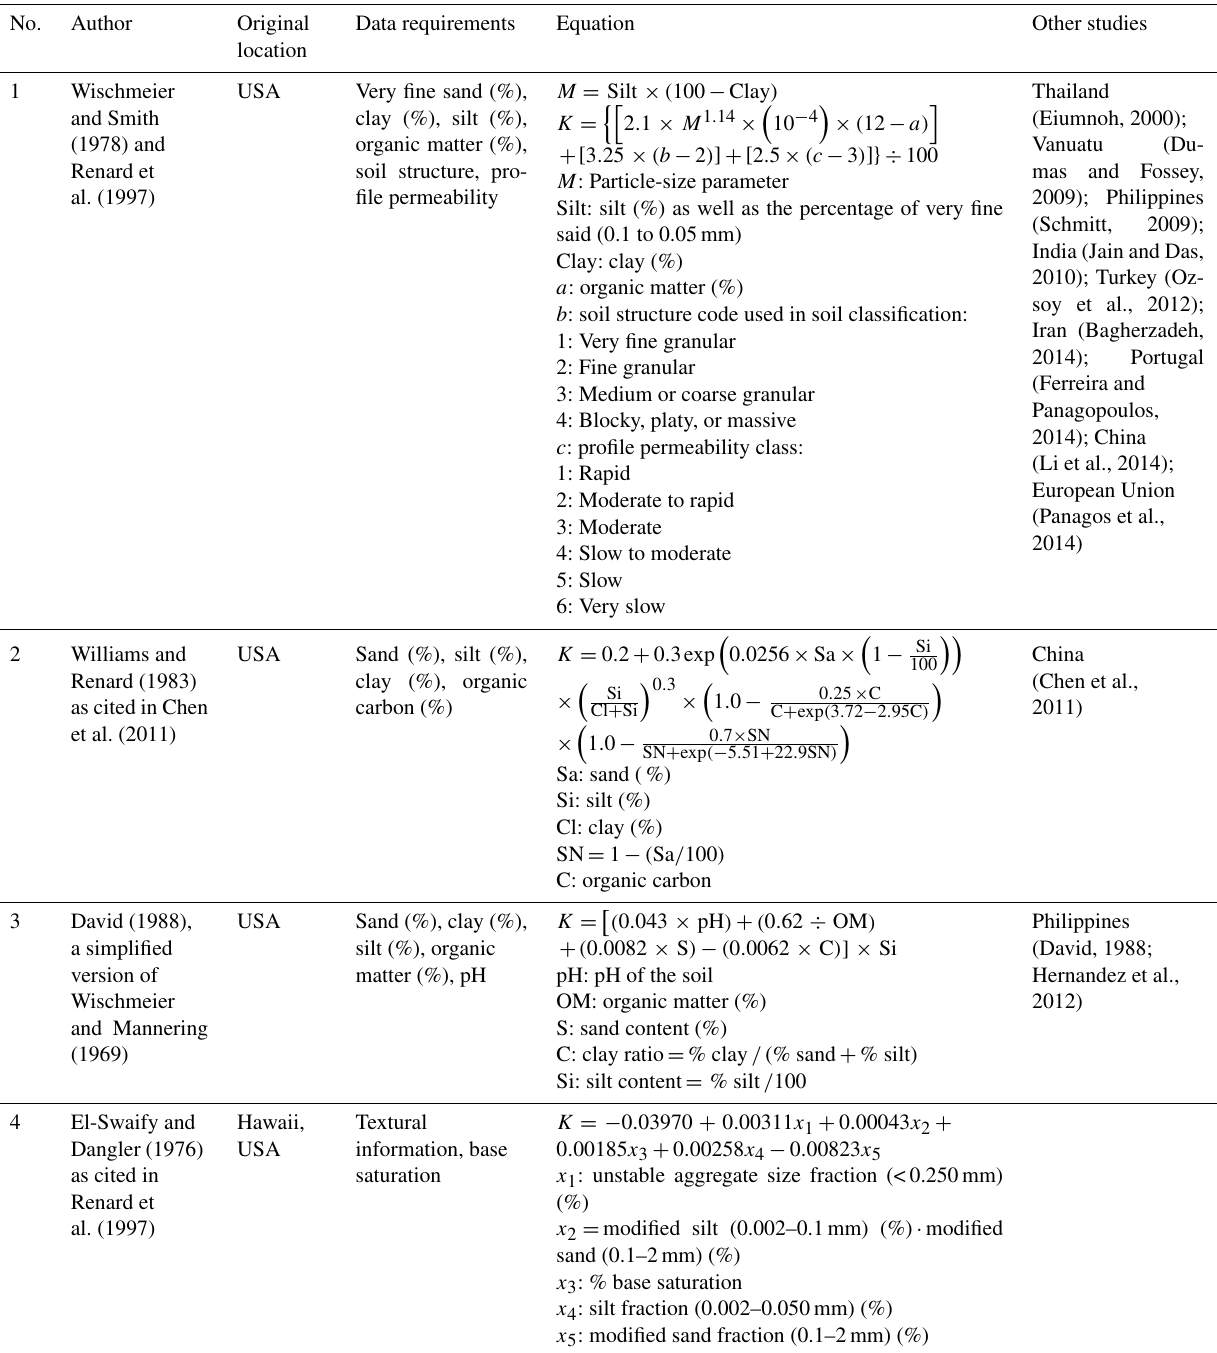
Table 3. Summary of different studies with soil erodibility equations, original locations, and other studies that used their equations. All of the equations in Table 3 use imperial units of soil erodibility: ton acre hour per hundreds of acres per foot per tonf per inch. Multiply by 0.1317 for conversion into SI units of metric ton hours per megajoules per